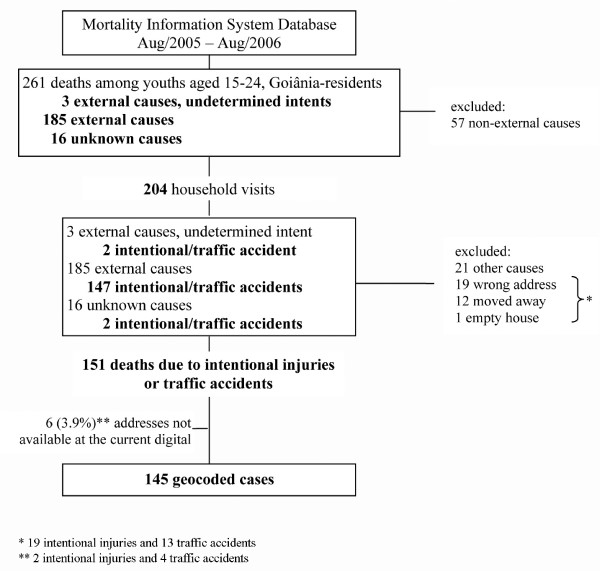
Flow chart for identification of violent deaths in youths. Goiânia, Brazil, Aug/2005-Aug/2006.